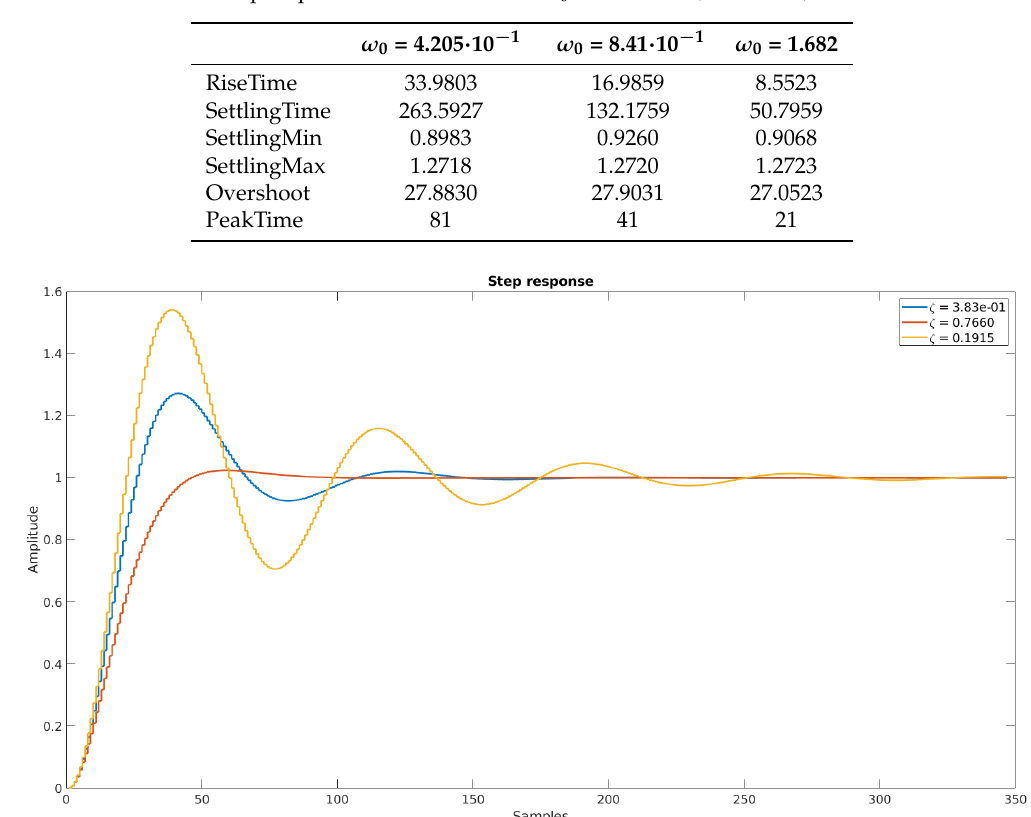
Table 2. Step response characteristics for ω 0 = 4.205 · 10 − 1 , 8.41 · 10 − 1 , and 1.682.